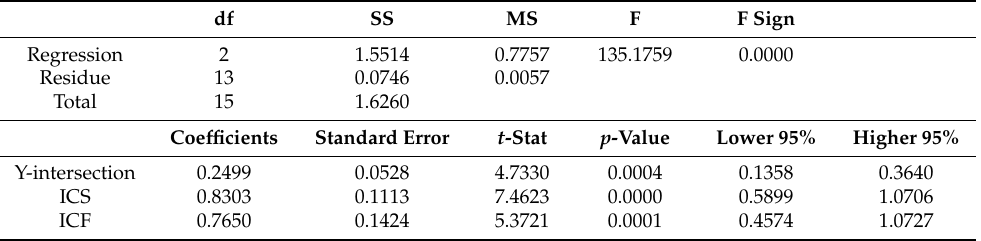
Table 9. Multiple regression model results for textile companies under study based on ICS and ICF. df SS MS F F Sign Regression